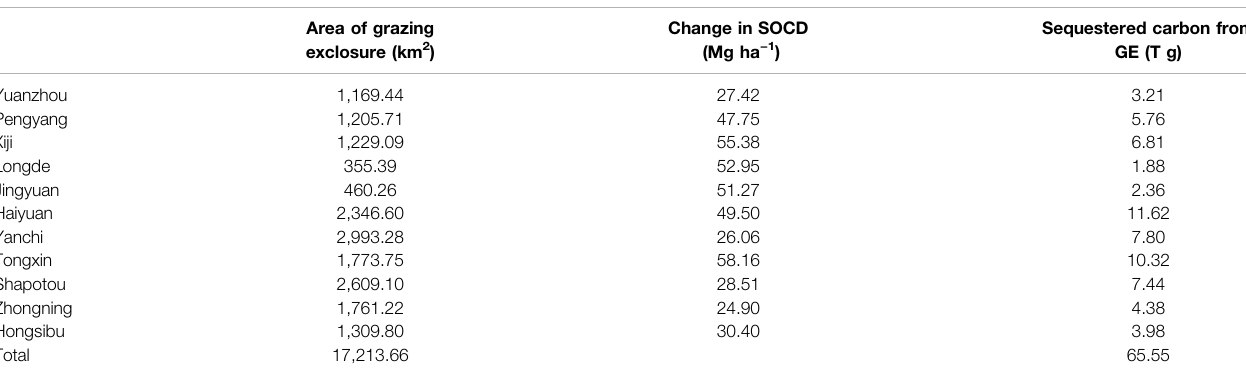
TABLE 1 | Carbon storage variation caused by grazing